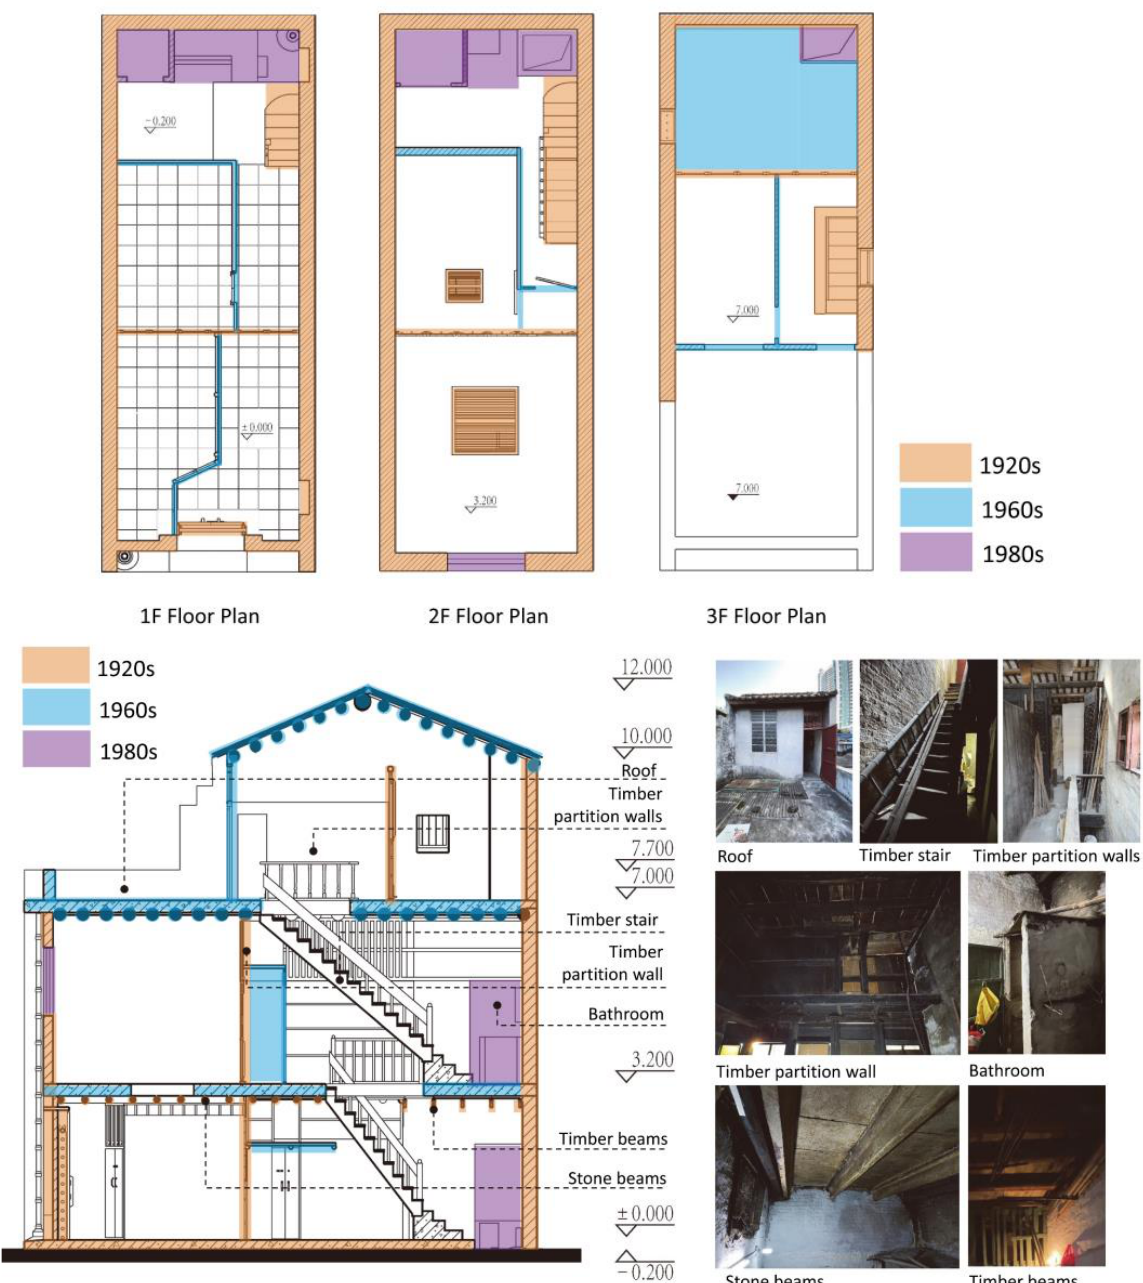
Figure 9. Observations and analysis of the different building construction periods (drawn by the students).